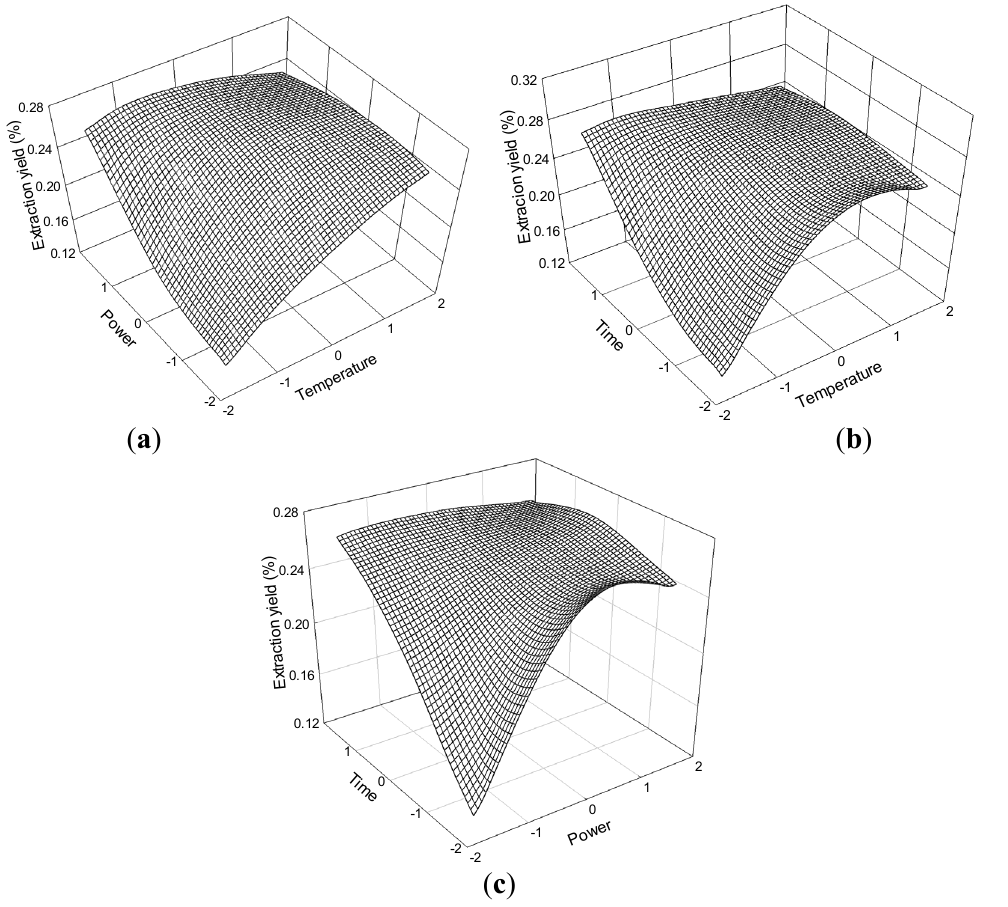
Figure 10. Response surface plots for the effects of ( a ) temperature/power ( b ) temperature/time ( c ) power/time on the extraction yield of senkyunolide